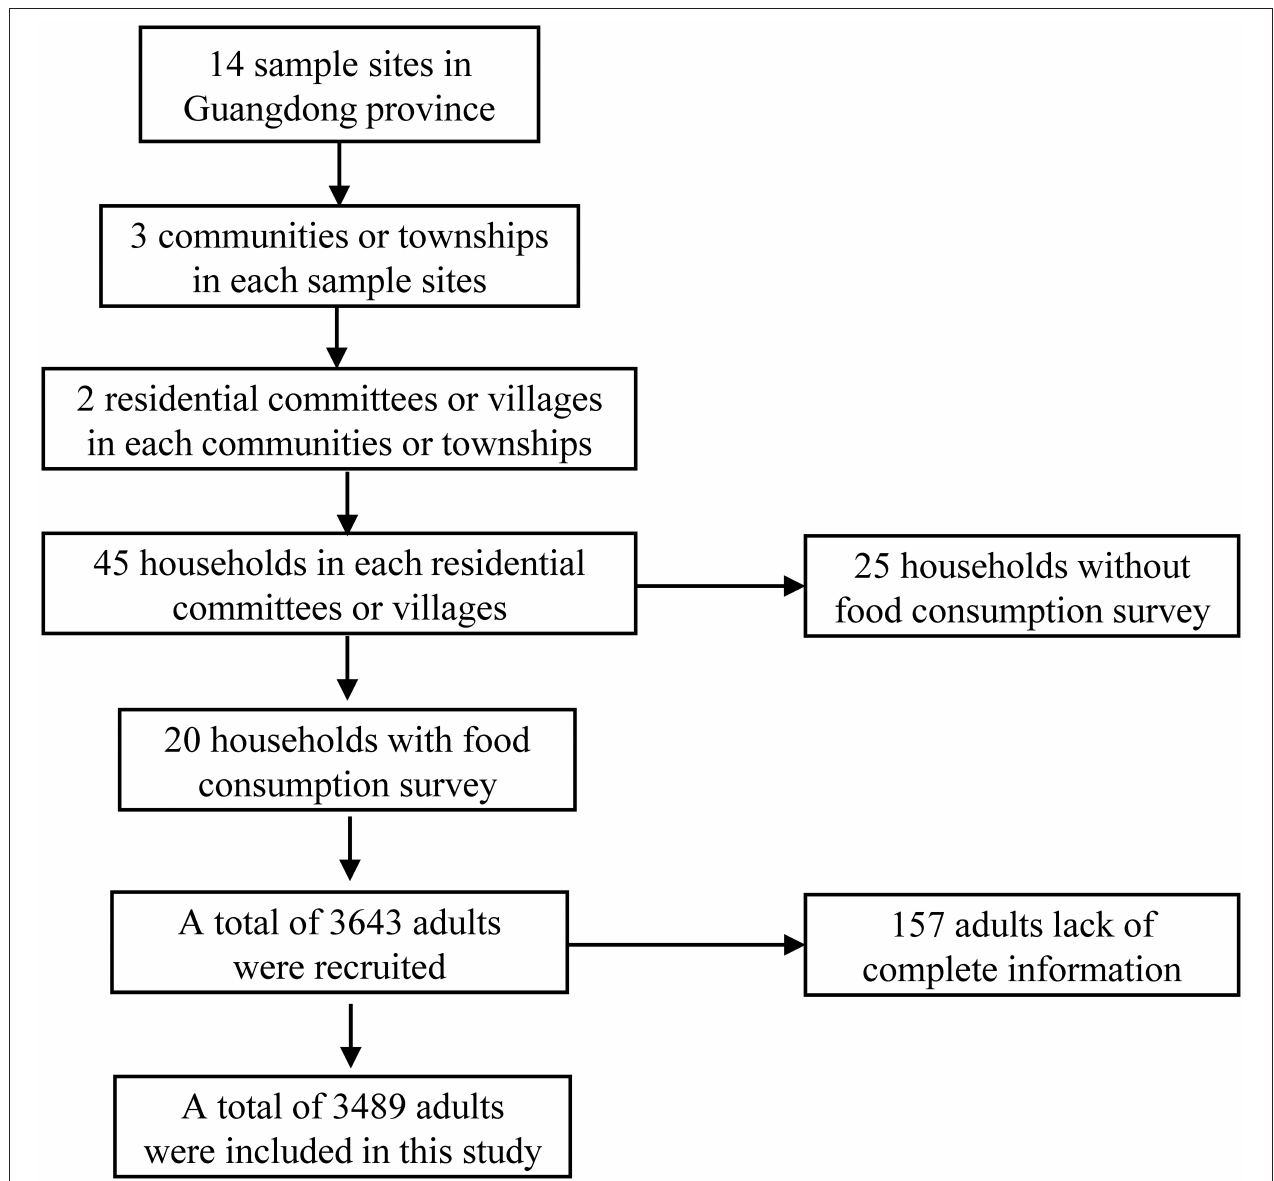
FIGURE 2 | Flow chart of selecting